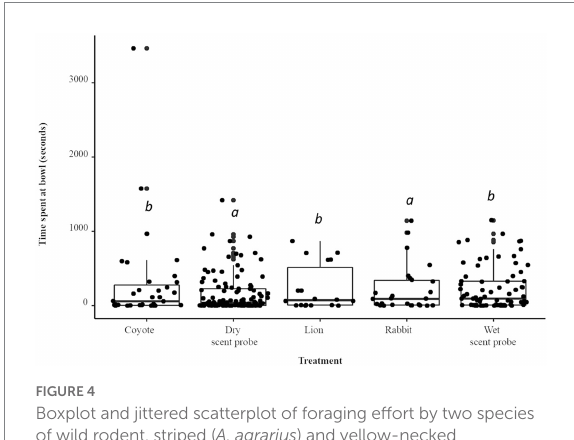
FIGURE 4 Boxplot and jittered scatterplot of foraging effort by two species of wild rodent, striped ( A. agrarius ) and yellow-necked ( A. flavicollis ) mice. Pairwise comparisons in superscript are significant at the level of p <